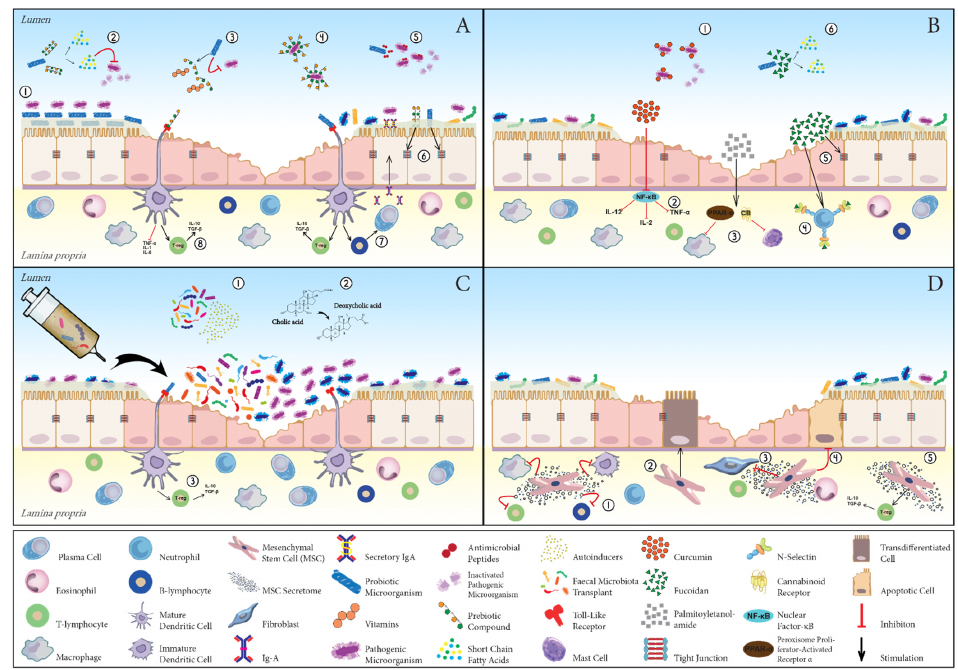
Figure 1. Schematic representation of the potential mechanisms underpinning beneficial effects of the main nonpharmacological treatment strategies in chronic inflammatory enteropathy of dogs (CIE). ( A ) Pre-, pro- and synbiotics: Probiotic microorganisms compete with pathogenic bacteria for adhesion sites at the level of the mucus layer or onto enterocytes (1); ferment prebiotic fibre with consequent production of postbiotics (e.g., short-chain fatty acids) (2); compete for growth sub- strates and produce and release essential dietary nutrients (e.g., vitamins) (3); inhibit the expansion of pathogenic microorganisms via the production of antimicrobial peptides (5); promote, together with prebiotic fibre compounds, tight-junction protein expression and strengthening of gut barrier function (6); and modulate immune responses by expanding the population of regulatory T cells (T- regs) and enhancing secretory immunoglobulin-A production (7). Additional direct mechanisms of action of prebiotics encompass blockage of pathogen adhesion by serving as ligand analogues (4) and immunoregulatory effect, exerted via the differential activation of inflammation-related recep- tors (8). ( B ) Phyto- and phycochemicals: curcumin is endowed with antibacterial activity against deleterious microbes (1) and functions as a potent anti-inflammatory compound by inhibiting nu- clear factor- κ B (NF- κ B) (2); palmitoylethanolamide (PEA) quenches phlogistic reactions through the activation of cannabinoid (CB) receptors and peroxisome proliferator-activated receptor (PPAR)- α (3); fucoidan hinders inflammatory cell egression from blood vessels via P- and L-selectin blockade (4), upregulates tight-junction protein claudin-1 expression (5) and is a source of fermentable fibre (6). ( C ) Faecal microbiota transplant: stool transplant reinstates gut homeostasis through a direct interaction between donor and recipient intestinal microbiota (1), restores normal faecal bile acid metabolism (2) and exerts immunoregulatory effects (3). ( D ) Stem cells: mesenchymal stromal cells suppress the activity of different immune cells (1), transdifferentiate into enterocytes (2), hamper fibrosis (3) and intestinal epithelial cell apoptosis (4) and induce T-reg differentiation and expansion (5). Author Contributions: Conceptualisation, M.I., R.J.C. and M.T.-M.; Writing—Original Draft Prep- aration, M.I.; Writing—Review and Editing, R.J.C. and M.T.-M. All authors have read and agreed to the published version of the manuscript.